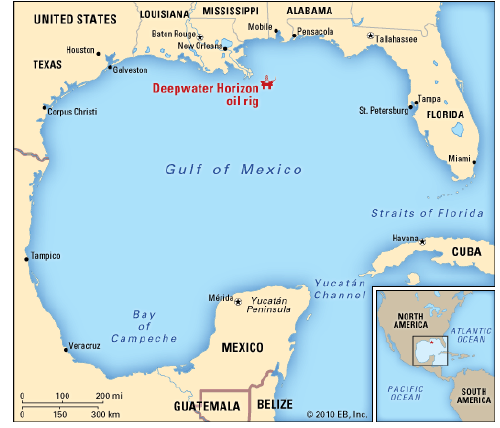
Figure 1. Map of the study area (Encyclopaedia Britannica).